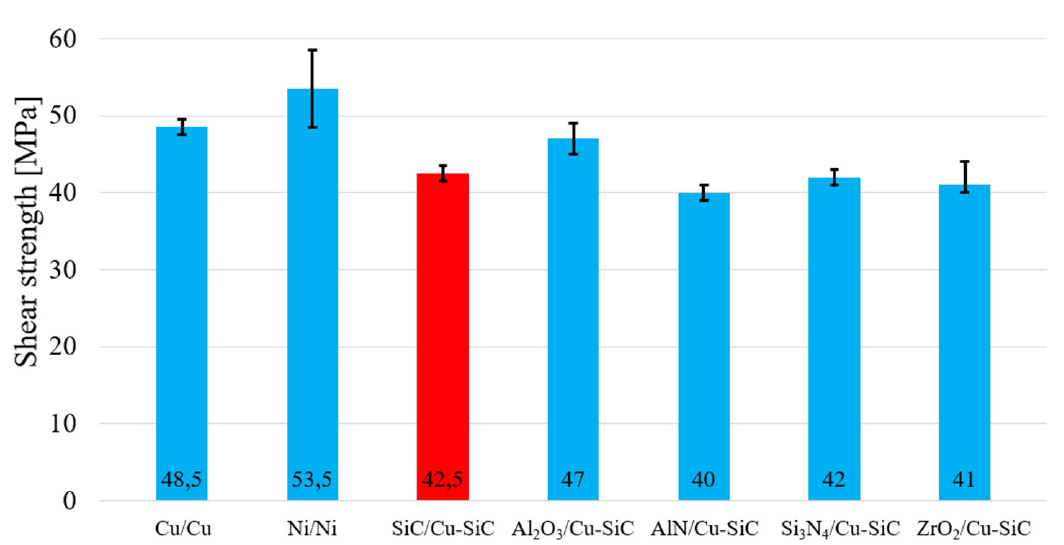
Figure 24 . Shear strength of soldered joints fabricated with the Sn5Sb3Ti solder . Figure 24. Shear strength of soldered joints fabricated with the Sn5Sb3Ti solder. For more precise identification of the mechanism of bond formation, the fractured sur- faces of joints were analyzed. Figure 25a,b shows the fractured surface on the boundary of the SiC/Sn5Sb3Ti/Cu–SiC joint. It is evident that the fractured surface from the side of SiC ceramics remained partially covered with the solder. Solder coverage was approximately 80%. Ductile fracture was observed in the solder. Planar analysis of the distribution of Si, Ti, Cu, Sn, and Sb elements on the fractured surface was performed, as documented in Figure 26b–f. The planar distribution of Si element shown in Figure 26b represents the SiC ceramics, and local spots (where the solder was pulled out) may be observed. From the distribution of Ti on the fractured surface, shown in Figure 26c, it may be concluded that Ti is bound to SiC ceramics and thus it contributes considerably to bond